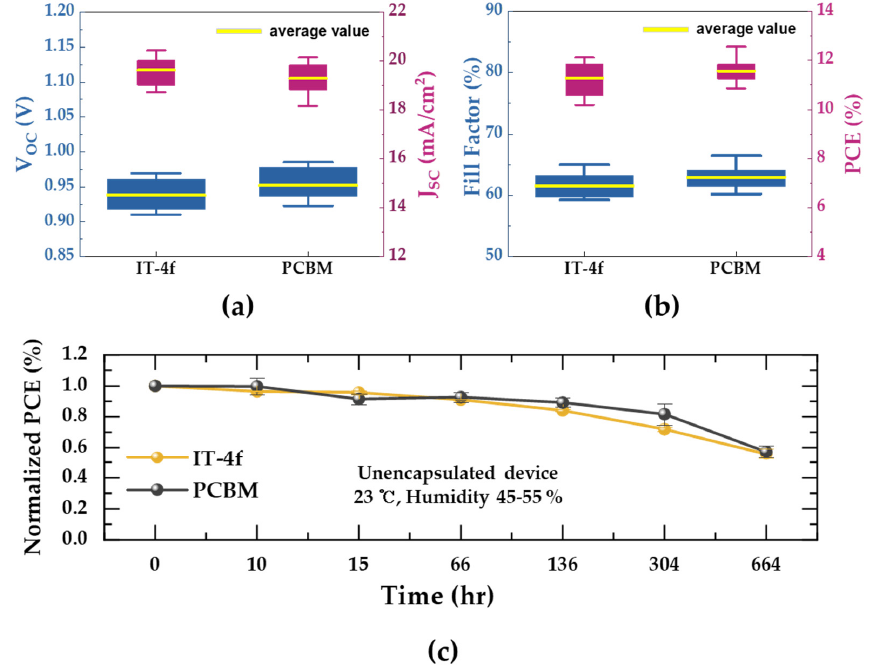
Figure 5. ( a , b ) Statistical photovoltaic cell parameters of the PSC with IT-4f and PCBM. ( c ) Changes in power conversion e ffi ciency of the PSC with IT-4f and PCBM.